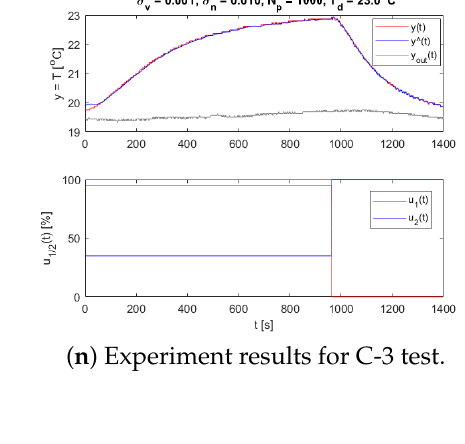
( m ) Experiment results for C-2 test. ( n ) Experiment results for C-3 test.